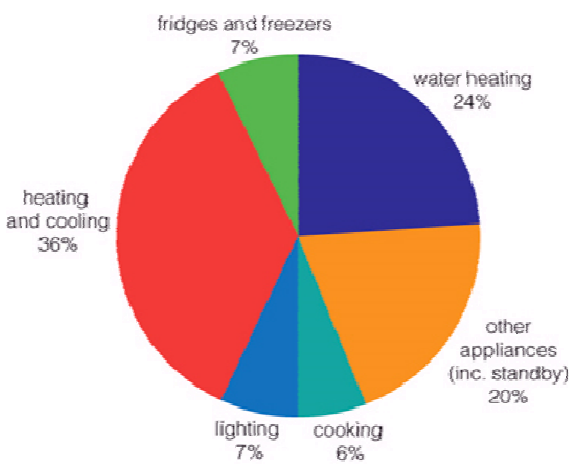
Figure 2. Average residential energy use [19].